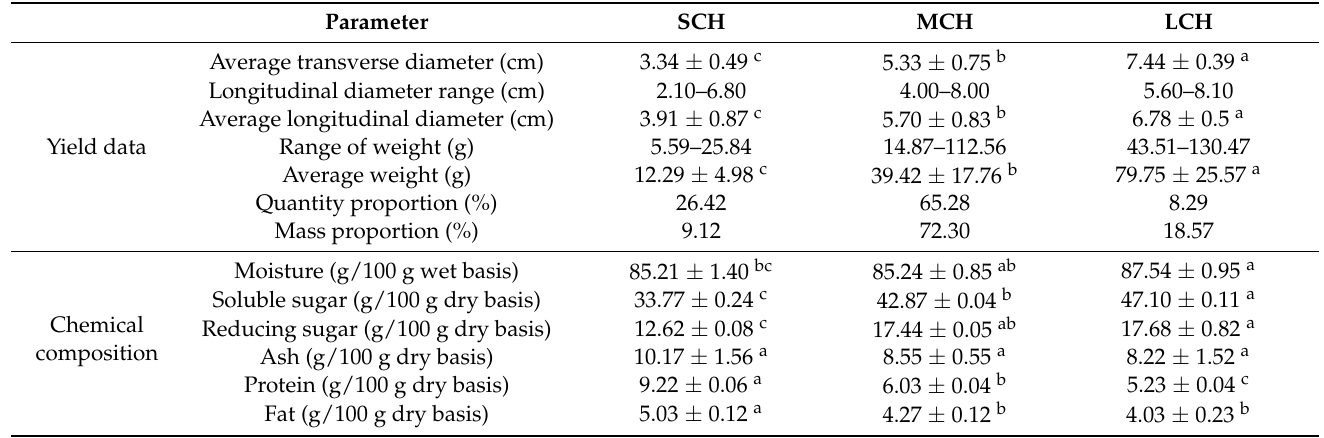
Table 1. Yield data and chemical composition of coconut haustorium 1